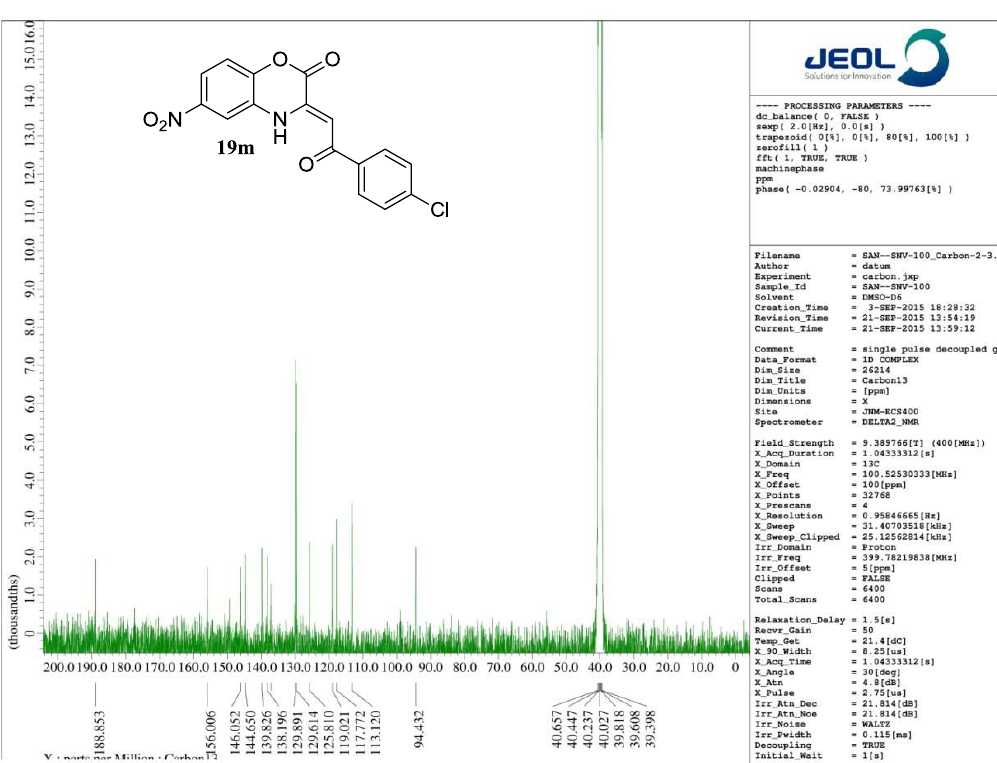
Figure 26. 13 C NMR Spectra of Compound 11m